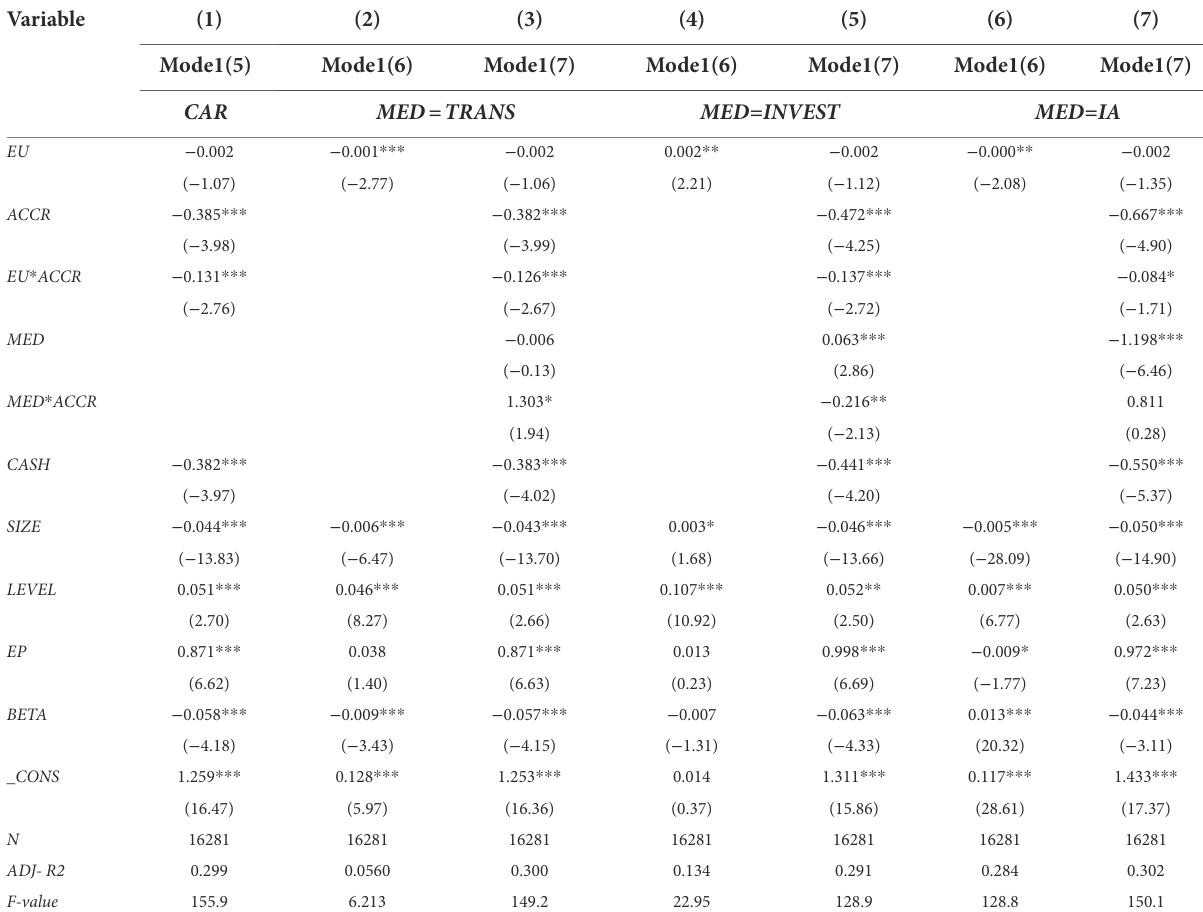
TABLE 11 The mediating effect